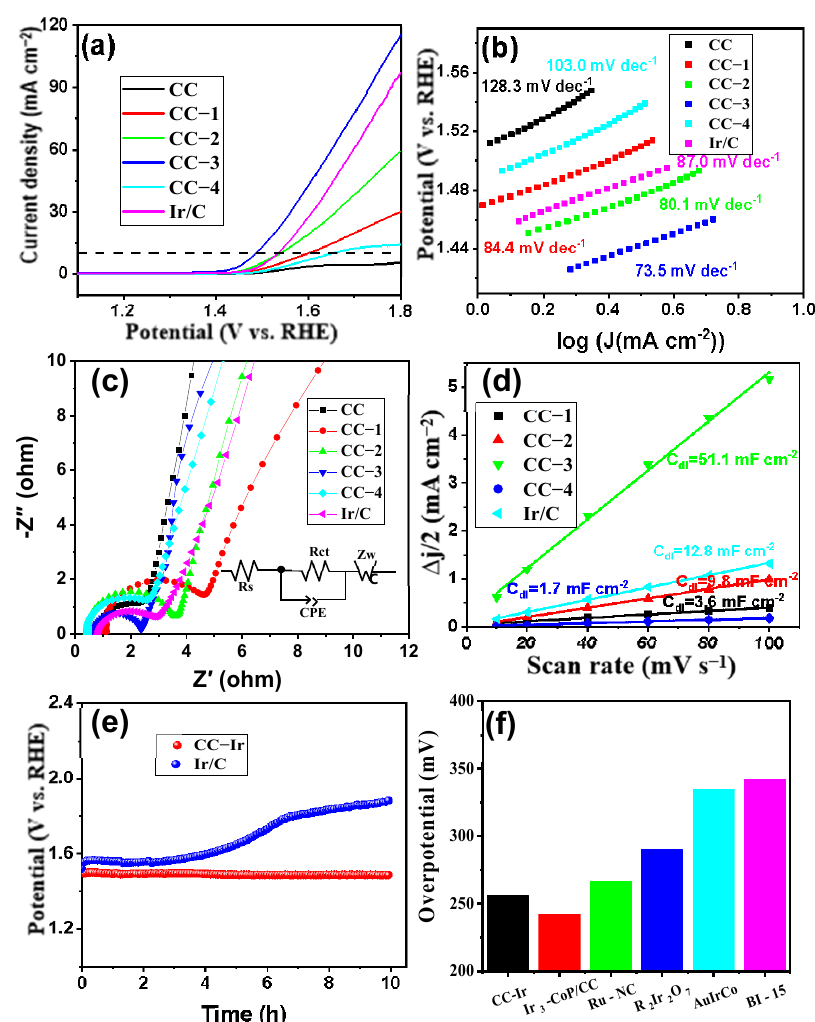
Figure 4. ( a ) LSV, ( b ) Tafel, ( c ) Nyquist plots (the illustration is the equivalent electrical circuit). ( d ) C dl curves, and ( e ) CP of Ir catalysts obtained at different electroplating temperatures, CC, and Ir/C in 0.5 M MSA. ( f ) Comparison of catalysts with high OER activity in acid solution reported in the various literature [39–43]. Slower reaction kinetics, and higher overpotential for OER led to the competitive precipitation of PbO 2 in the recovery of lead by lead methanesulfonate electrolysis. In this work, CC-Ir was employed as an anode catalyst for lead methanesulfonate electrolysis, in order to improve the efficiency of the electrolytic process. The effects of lead ion concen- tration, MSA concentration, and the temperature of the electrolyte on OER and PbO 2 pre- cipitation were studied. CC-Ir was firstly run 50 cycles at the rate of 50 mV s − 1 in the voltage range of 0.2–2.2 V (vs. RHE) in 1 M MSA electrolyte before lead methanesulfonate electrolysis. Figure 5a shows the influence of Pb 2+ concentration in 1 M MSA electrolytes. With the increase of Pb 2+ concentration from 0.01 to 0.6 M, the oxygen release rate first increased and then de- creased, reaching the maximum at a Pb 2+ concentration of 0.2 M. Furthermore, at this Pb 2+